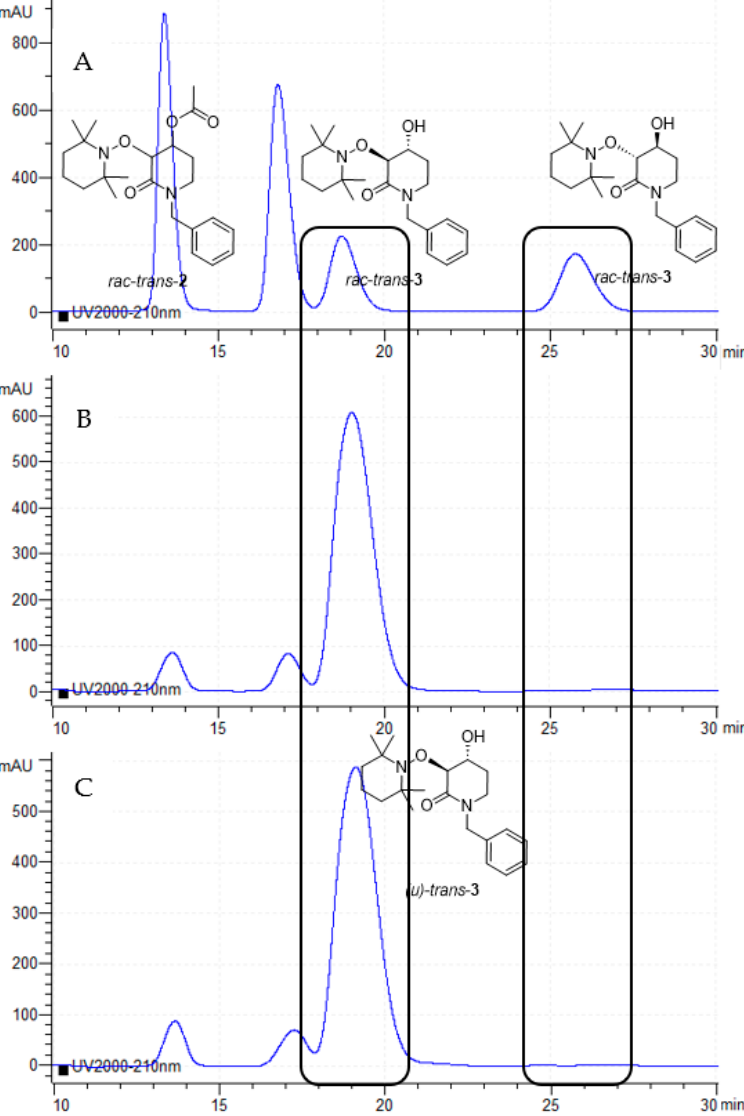
Figure 3. ( A ) Chiral-HPLC chromatogram of the 2:1 mixture of both rac-trans - 2 and rac-trans - 3 . ( B ) Chiral-HPLC chromatogram of the CALB-catalyzed de-acylation reaction at 24 h. ( C ) Chiral- HPLC chromatogram of the CALB-catalyzed de-acylation reaction at 72 h. Along with the Chiral-Column HPLC Analysis, the NMR technique was used to determine the conversion percentage of the enzyme-catalyzed-mediated